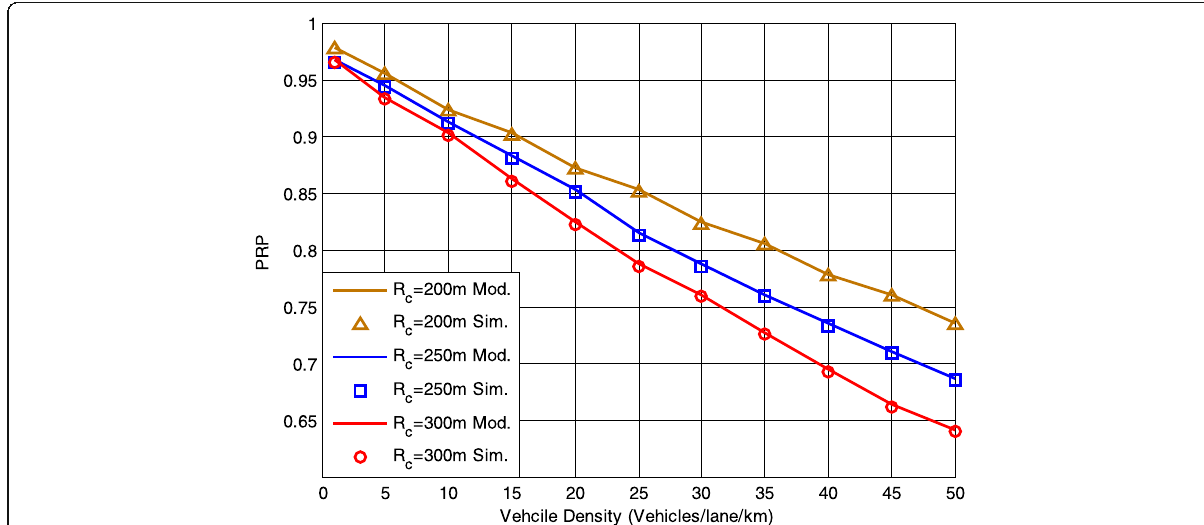
Fig. 12 Comparison of results for the analytic model and simulations of PRP with hidden terminals for various communication ranges with respect to vehicle density, W 0 = 16, R = 6 Mbps, λ = 10 Hz, D = 186